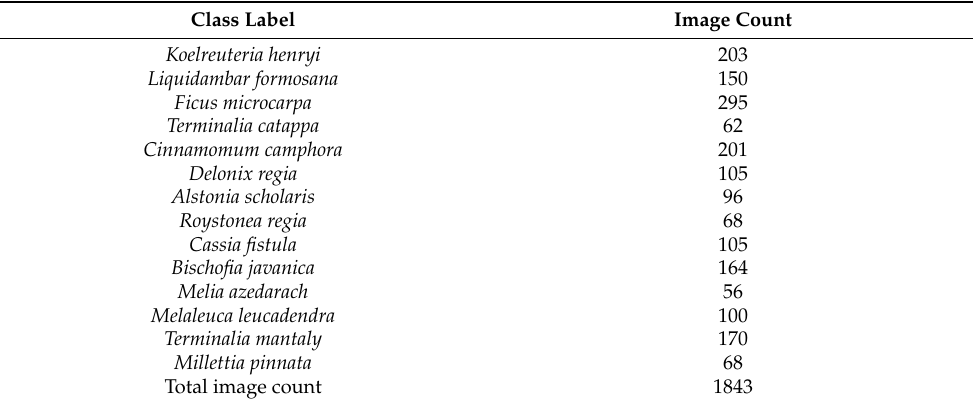
Table 3. Image count per class in the 14 tree species